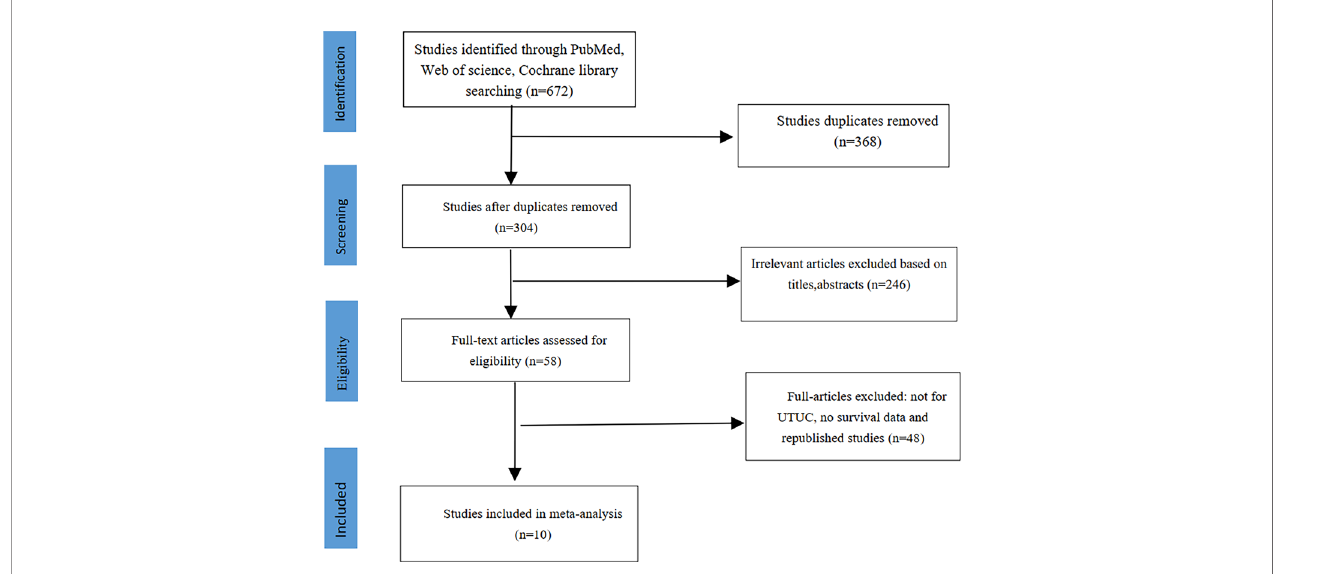
FIGURE 1 | The fl owchart showing study search and selection